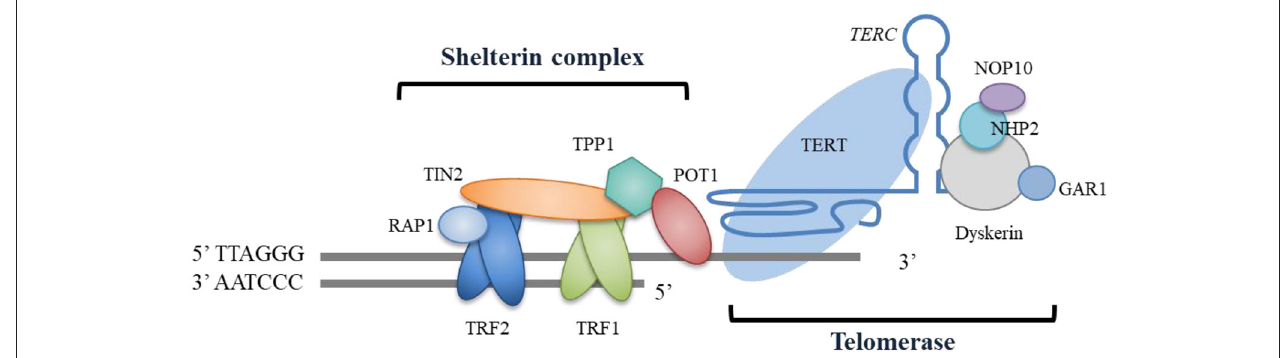
FIGURE 1 | Schematic telomere structure and essential components. Human telomeric repeated DNA is protected by the shelterin complex, which consists of the protein components TRF1, TRF2, RAP1, TIN2, TPP1, and POT1. The ends of telomeres are bonded with telomerase, which is comprised of the catalytic subunit of TERT and the telomerase RNA component of TERC , and this exerts its effects by adding telomeric sequences to the telomeric ends. The telomerase also has other accessory components, including dyskerin, NHP2, NOP10, and GAR1. The function of these accessory components is to stabilize the TERC .